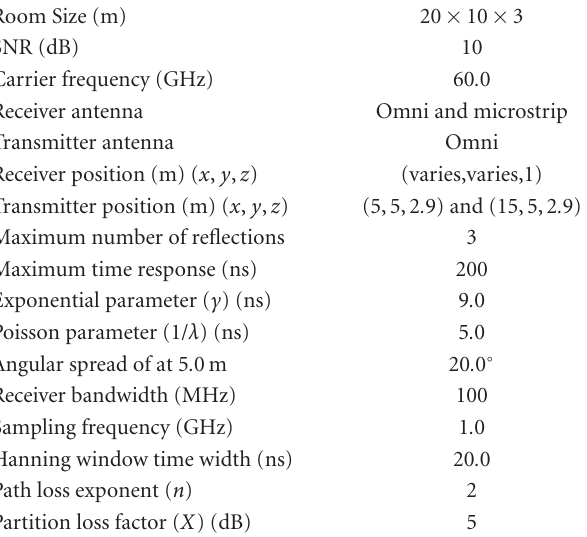
Table 1: Parameters used in OFDM